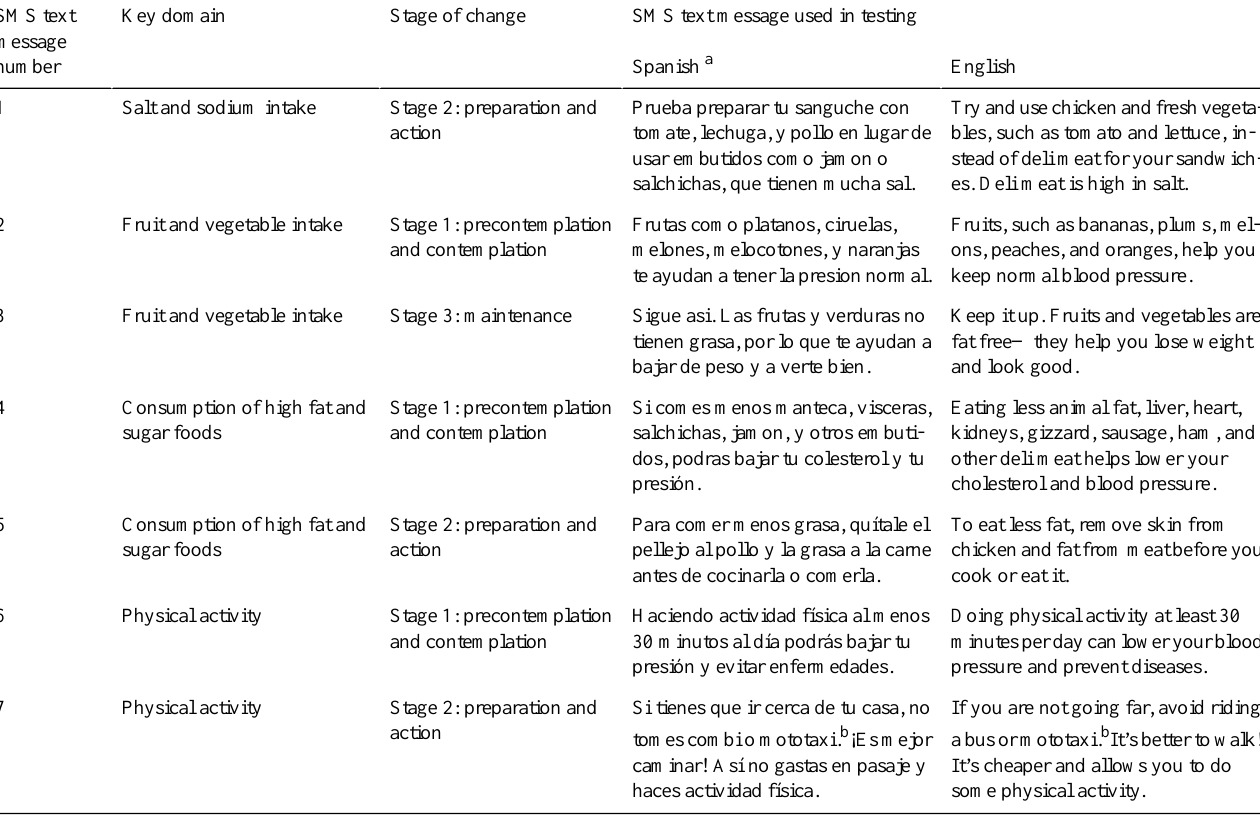
Table 3. Example of a subset of SMS text messages used for validation (set 3,